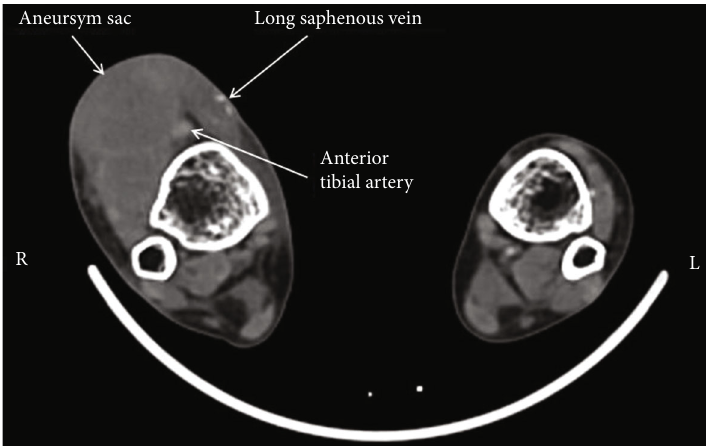
Figure 2: Computed tomography of the patient ’ s right ankle aneurysm shows calci fi cation in the saphenous vein and an intact